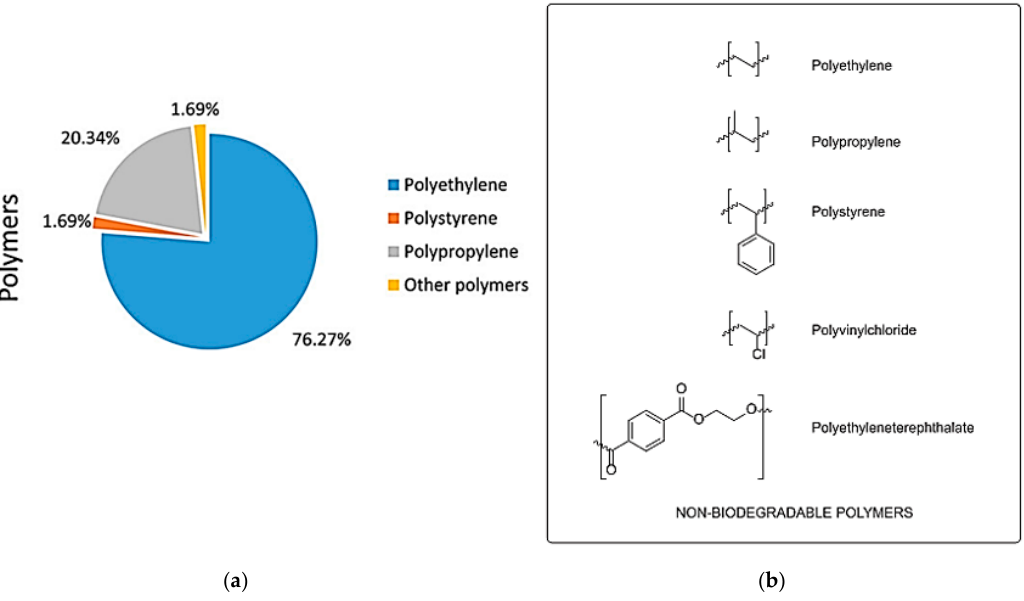
Figure 1. Microplastic abundance in the Pelagos Sanctuary ( a ) [34]. Chemical structures of non-biodegradable polymers ( b ) [35]. (Reprinted with permission from [35]. Copyright 2017 Elsev.).